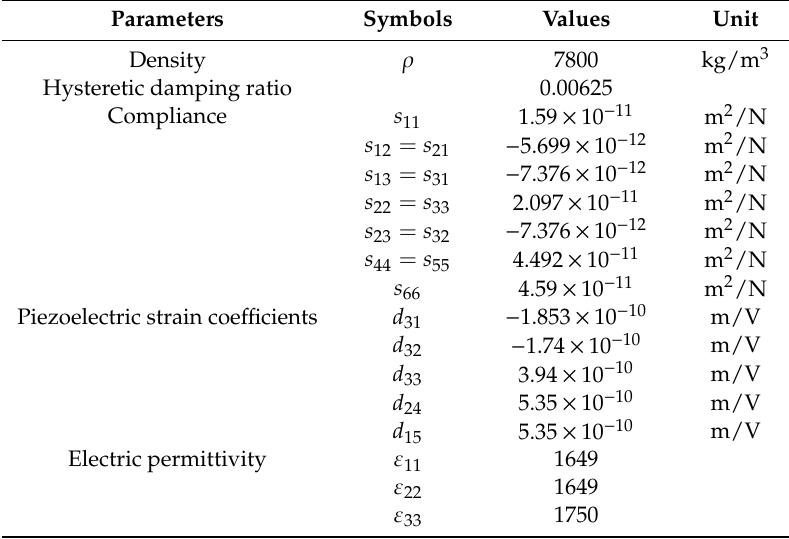
Table 1. Piezoelectric properties